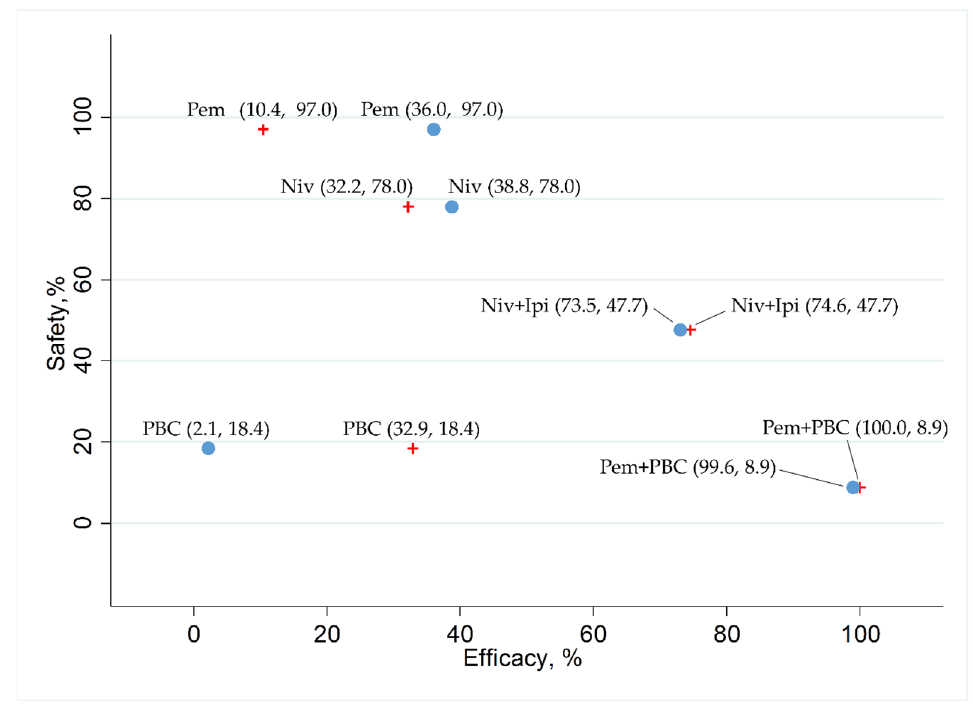
Figure 8. The surface under the cumulative ranking curve (SUCRA) of the efficacy in progression-free survival (PFS) in a group of patients with programmed cell death ligand 1 (PD-L1) expression levels of 1% or more (presented as red crosses), in a group of patients with PD-L1 expression levels of 50% or more (presented as blue circles), and safety in any Grade 3–5 drug-related adverse events (G3–5AEs) in the overall population of the five therapeutic regimens (Niv+Ipi, Pem+PBC, Pem, Niv, and PBC). Data are presented as (SUCRA in PFS and SUCRA in G3–5AEs) with each plot of the five therapeutic regimens. In terms of efficacy in patients with PD-L1 expression levels of 1% or more (presented as red crosses), Pem+PBC ranked the highest, followed by Niv+Ipi, PBC, Niv, and, finally, Pem. In terms of efficacy in patients with PD-L1 expression levels of 50% or more (presented as blue circles), Pem+PBC ranked the highest, followed by Niv+Ipi, Niv, Pem, and, finally, PBC. However,